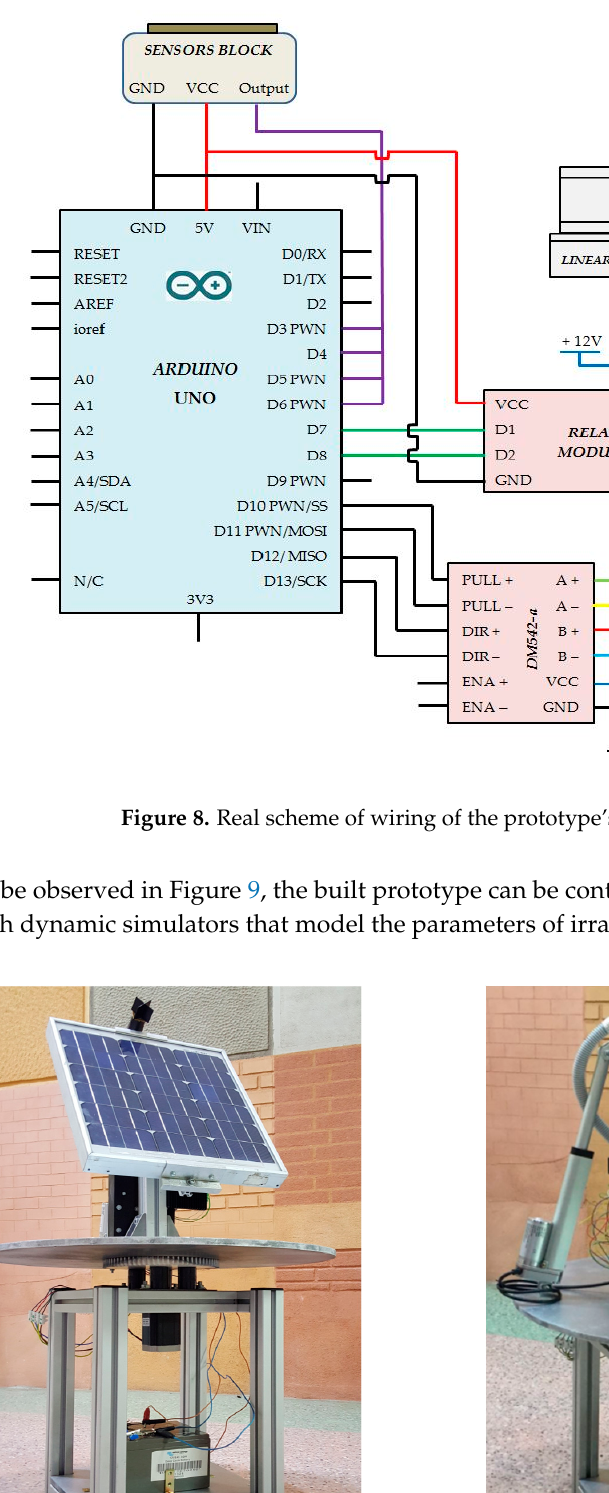
Figure 9. Designed photovoltaic solar tracker: ( a ) Front view; and ( b ) Side view.